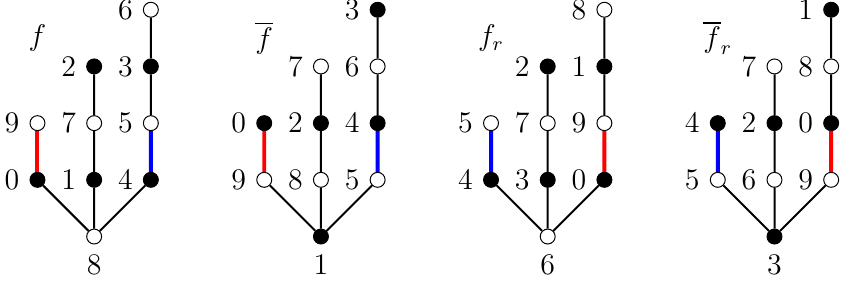
Figure 1: Four related α -labelings of the same